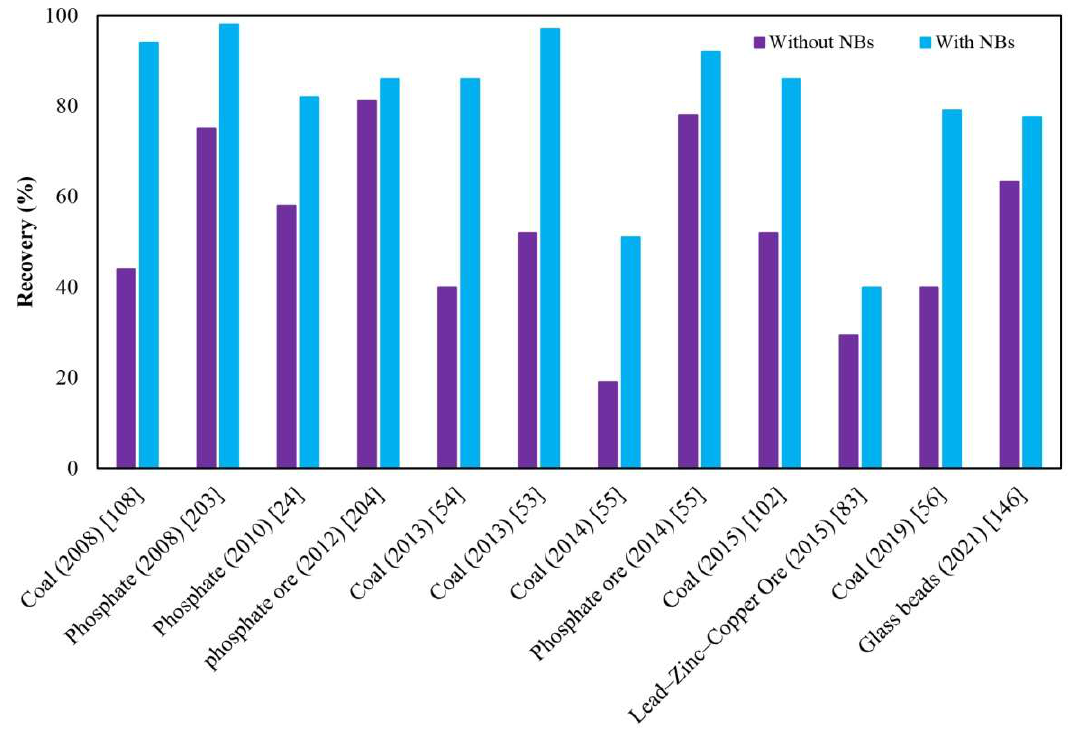
Figure 11. Studies about NBs-assisted flotation in column flotation cells, 2008–2021 [24,53–